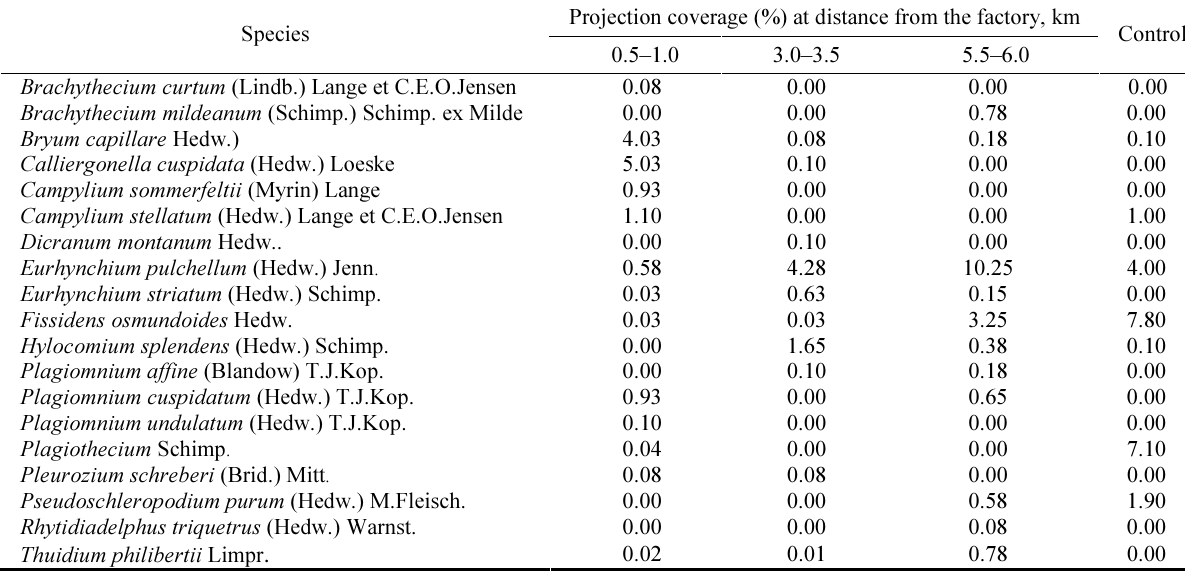
% ) at different distances from the pollution source and in control forest Table 5. Briophyte species and their projection coverage ( stand (an average data from 36 vegetation sample quadrates at each distance and control) Projection coverage (%) at distance from the factory, km Species 0.5–1.0